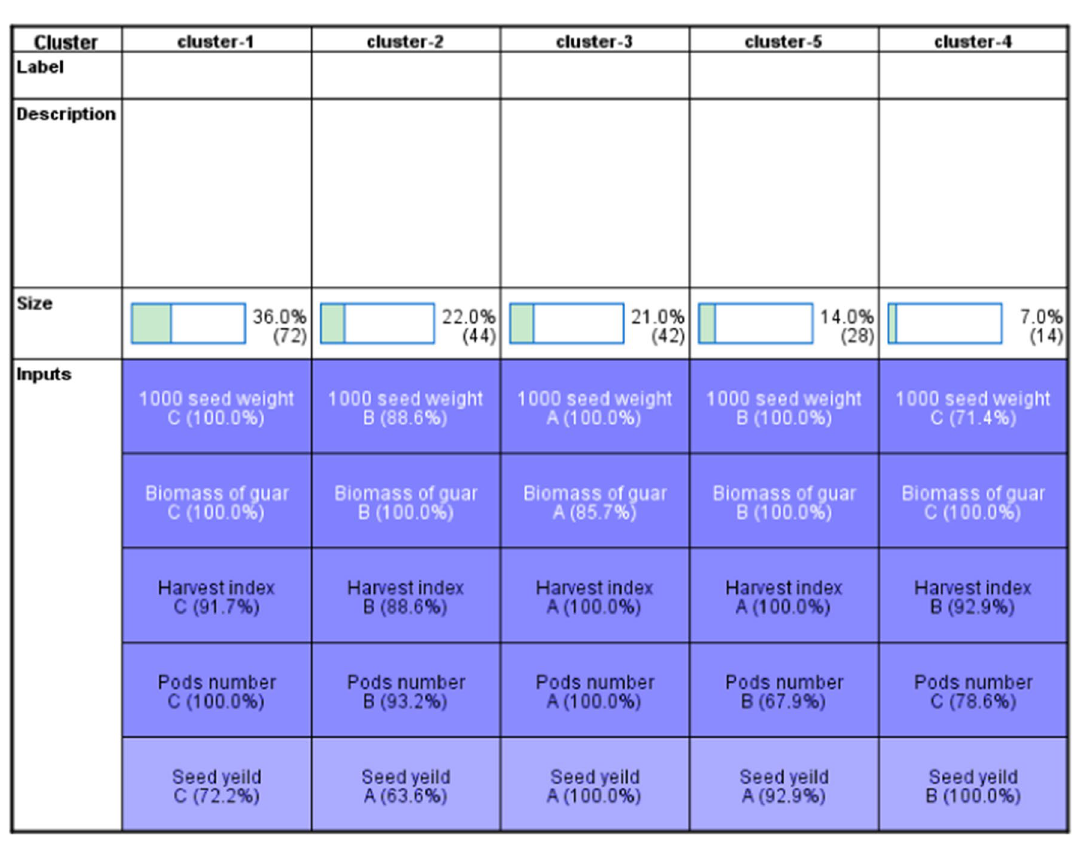
Fig. 5 The contribution percentage of five quantitative traits of guar beans in the formation of clusters